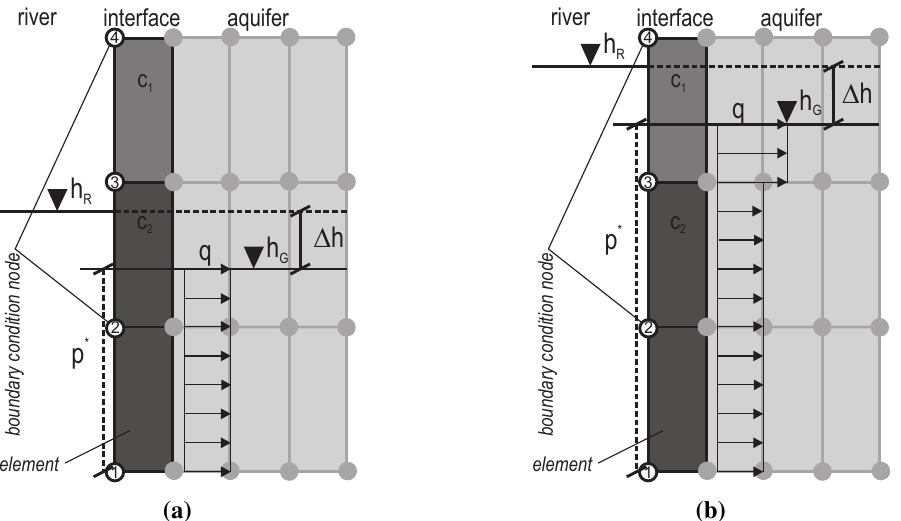
Figure 3. Wetted perimeter p ∗ and leakage rate q for different water levels h same head difference ∆ h . The interface layer between the aquifer and the river is modeled > c as heterogeneous ( c ). ( a ) Low river stage and low groundwater level; ( b ) high river 1 2 stage and high groundwater